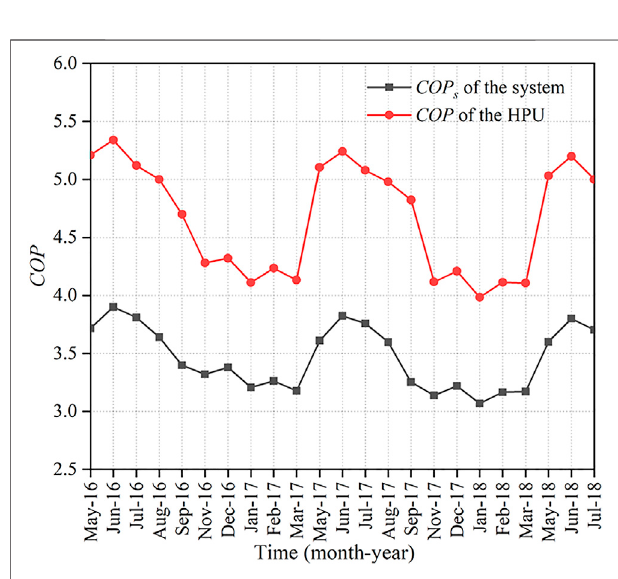
FIGURE 13 | COP as a function of time of SWC system and HPU from May 2016 to Jul 2018.